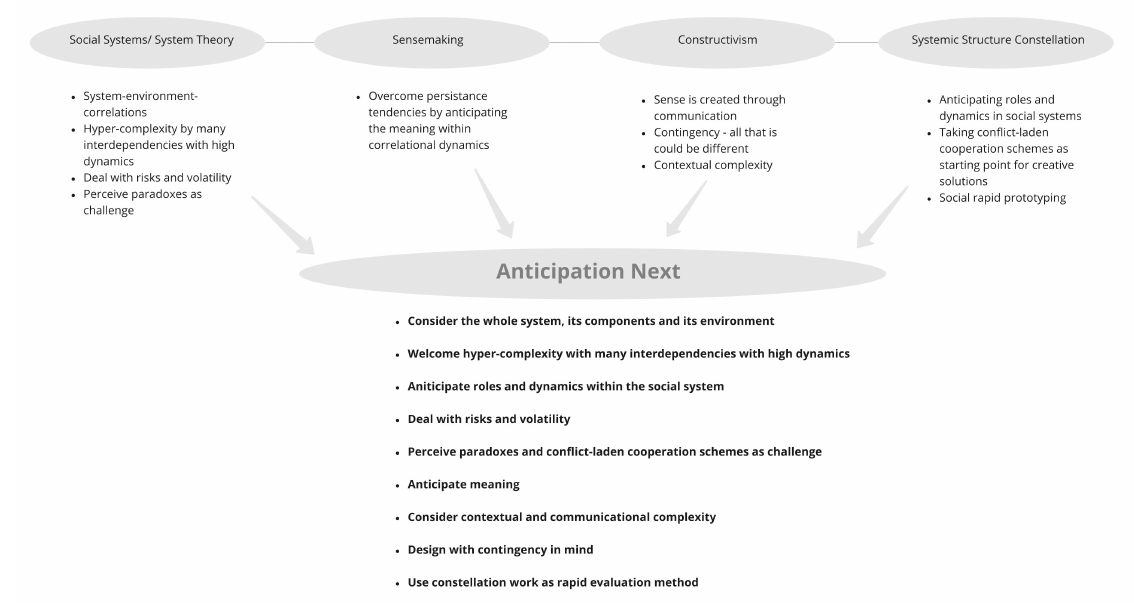
Figure 1. Anticipation Next Conceptual Scheme, authors’